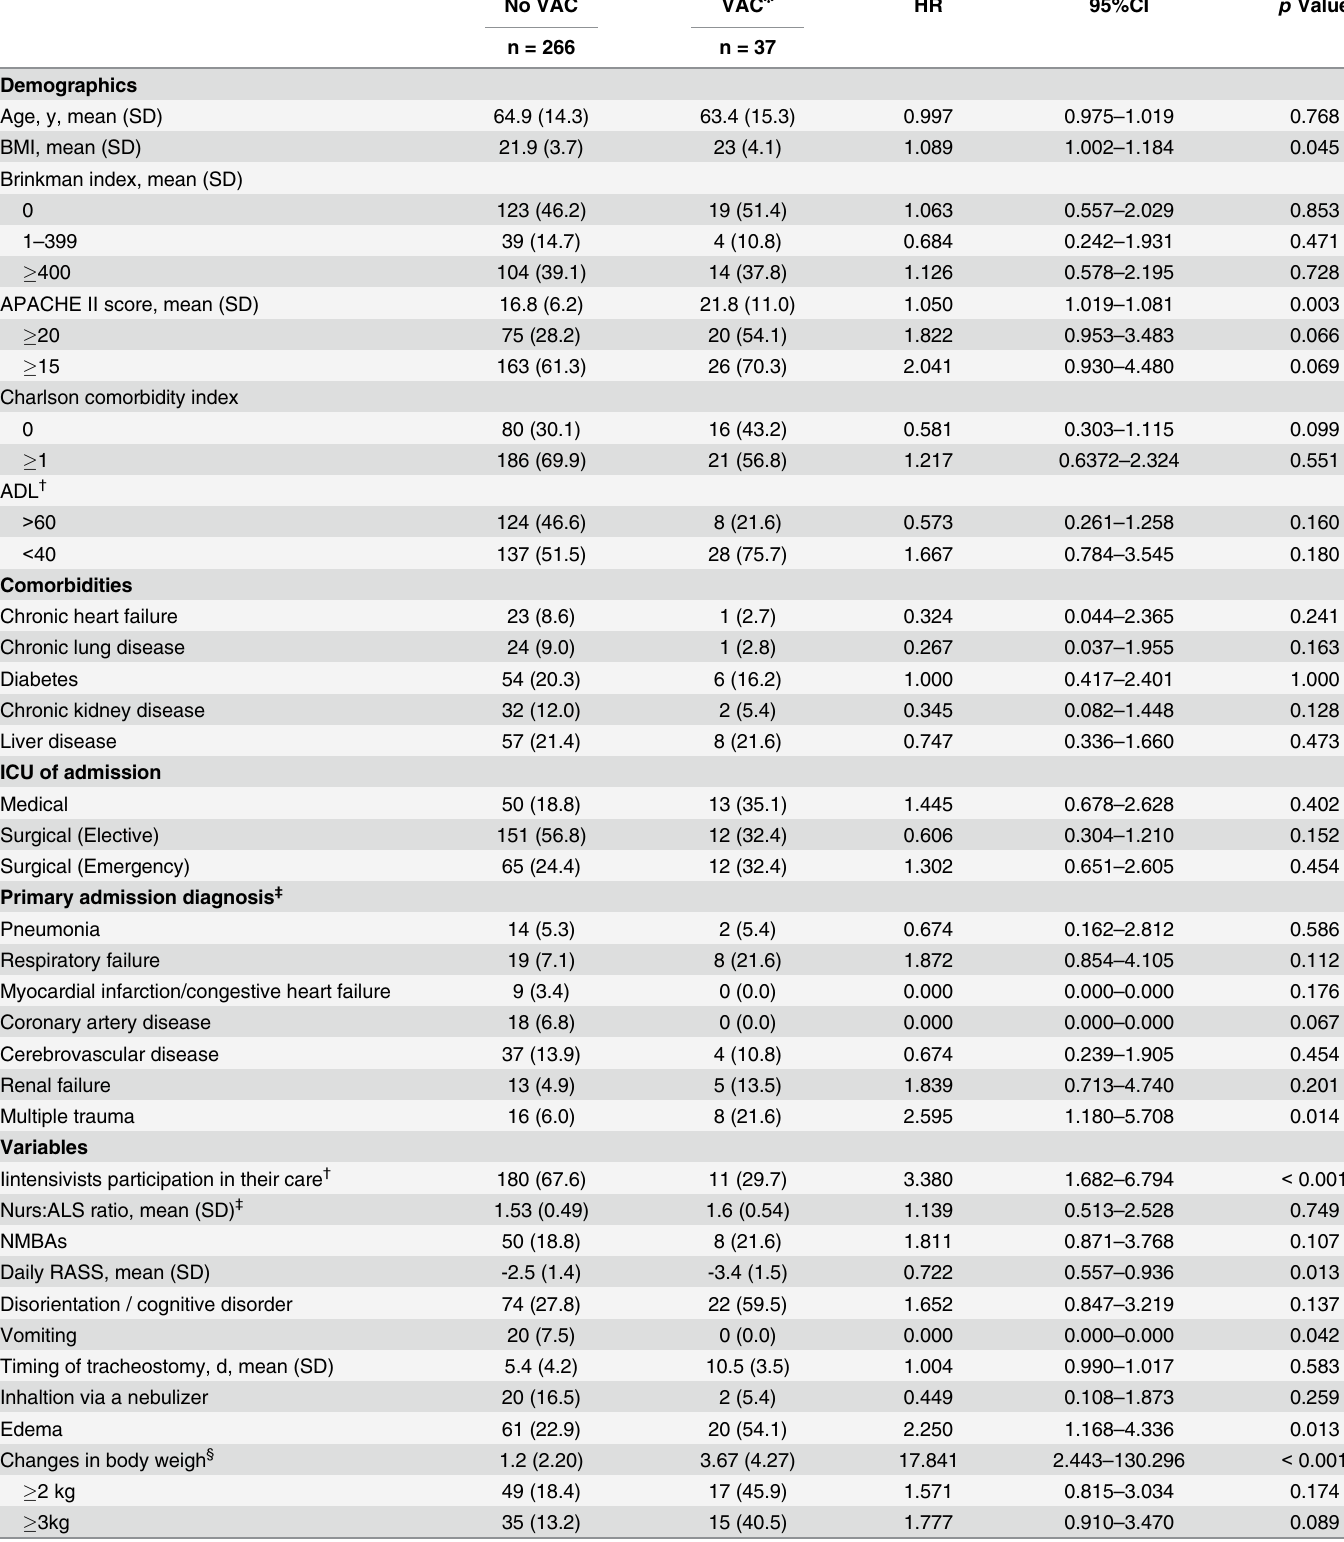
Table 3. Ventilator-associated conditions univariate